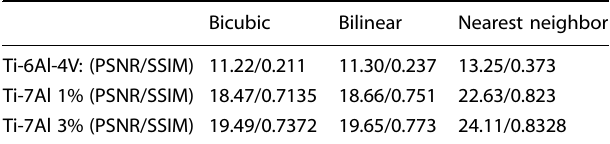
Table 2. PSNR/SSIM comparison for 4× algorithmic scaling: PSNR/ SSIM values for bilinear, bicubic, and nearest neighbor are consistently lower than network-based methods.